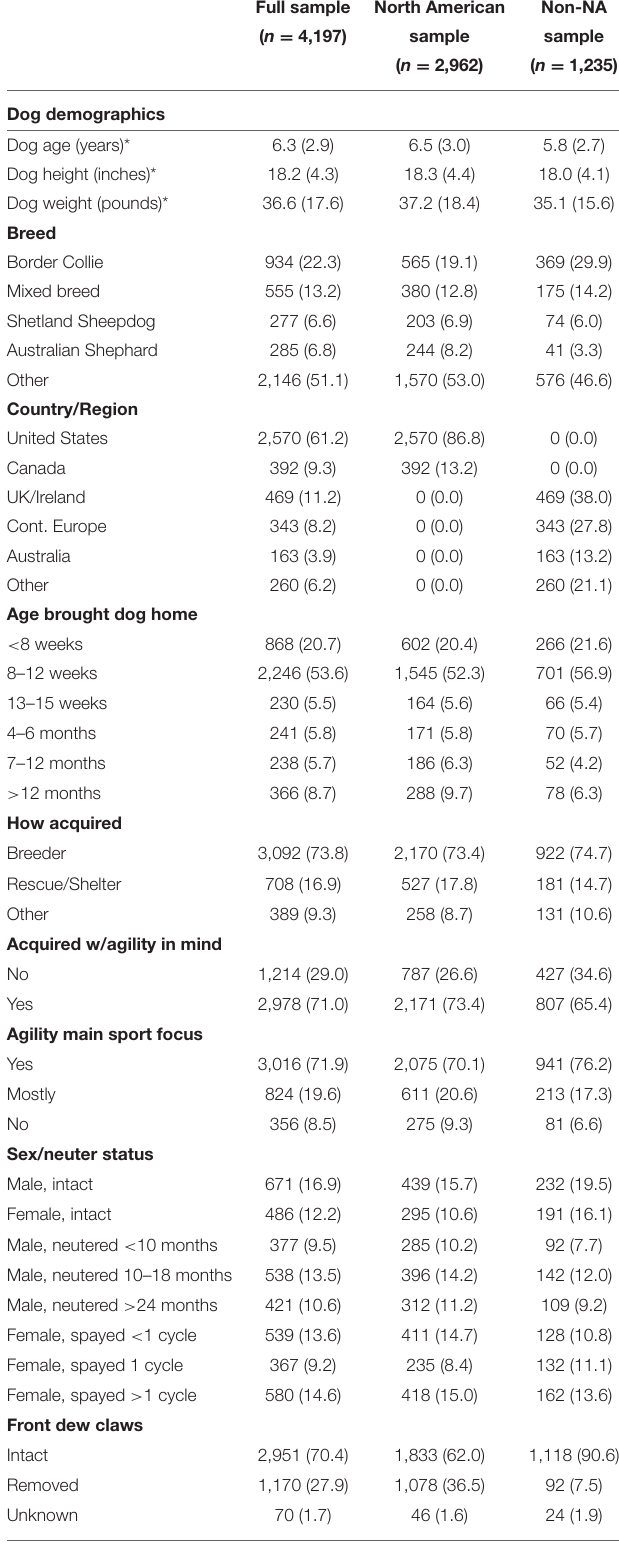
TABLE 1 | Descriptive statistics of the sample ( n = 4,197 dogs and